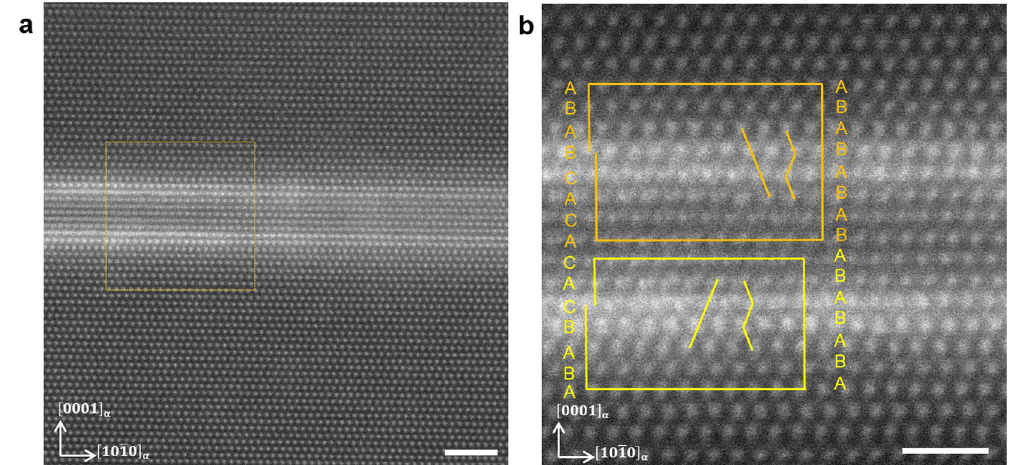
Figure 2. Structural evolution from GP zones to LPSO building blocks. Atomic scale HAADF-STEM images of the Mg-1Y-0.5Zn alloy after solution annealing for 10 h at 500 °C. Beam direction is [1210] . ( a ) Two Y/Zn enriched basal plane defects. The basal plane defects on the right side of the image show an hcp stacking sequence which changes to the local fcc stacking sequence characteristics for the LPSO building blocks on the left side of the image. Scale bar width is 2 nm. ( b ) A magnified image of the orange square region in ( a ). The upper basal plane defect (orange Burgers circuit) changes its stacking sequence from an ABAB-type hcp stacking to an ABCA and the lower basal plane defect (yellow Burgers circuit) to an ACBA fcc stacking. Scale bar width is 1